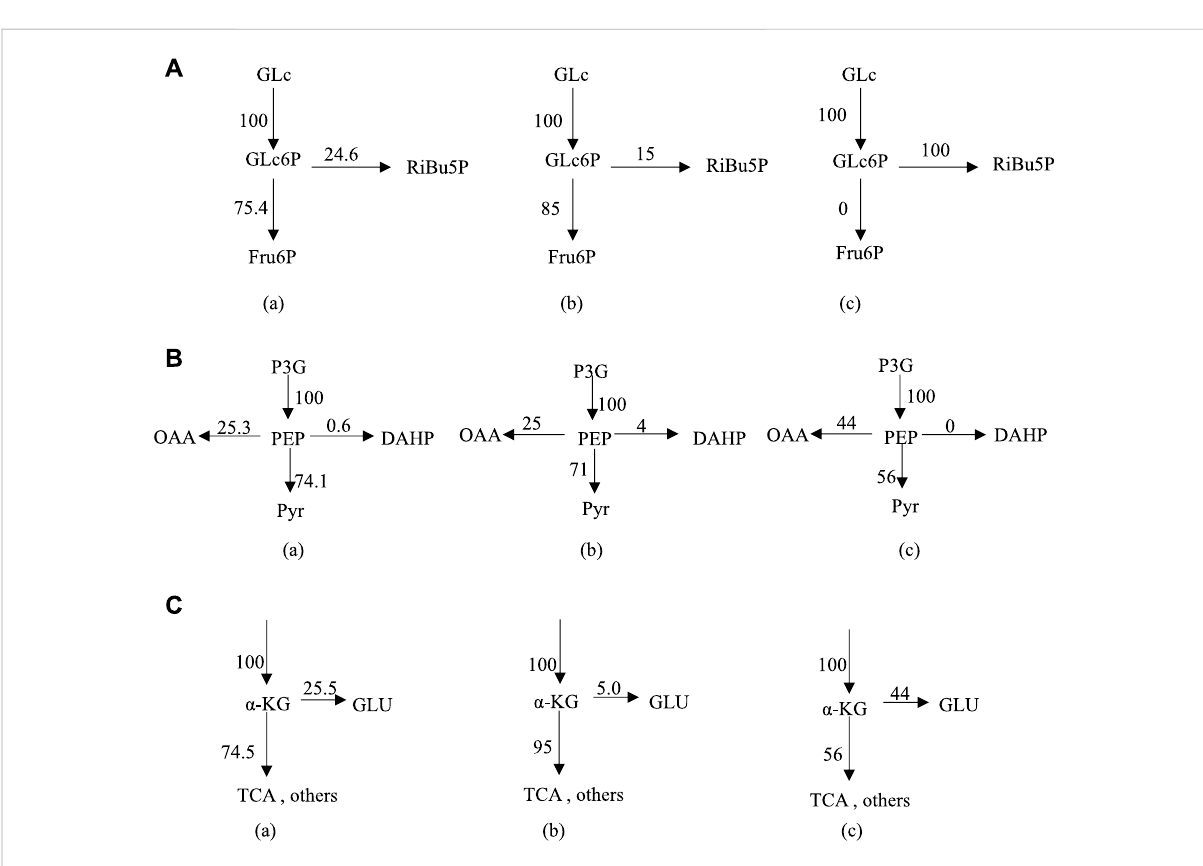
FIGURE 3 Metabolic fl ux distribution at Glc6P node (A) , PEP node (B) and α -KG node (C) under different conditions; (A) 9.8 g L − 1 phosphate, (B) 24.8 g L − 1 phosphate, (C) ideal condition. Enzyme control analysis for metabolic fl ux in Thr biosynthesis